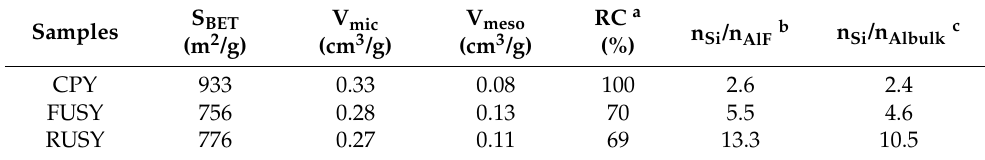
Figure 1. XRD patterns ( a ) and nitrogen adsorption/desorption isotherms ( b ) of the three Y- zeolite samples. Table 1. Pore structure parameters and compositions of the three Y-zeolite samples.